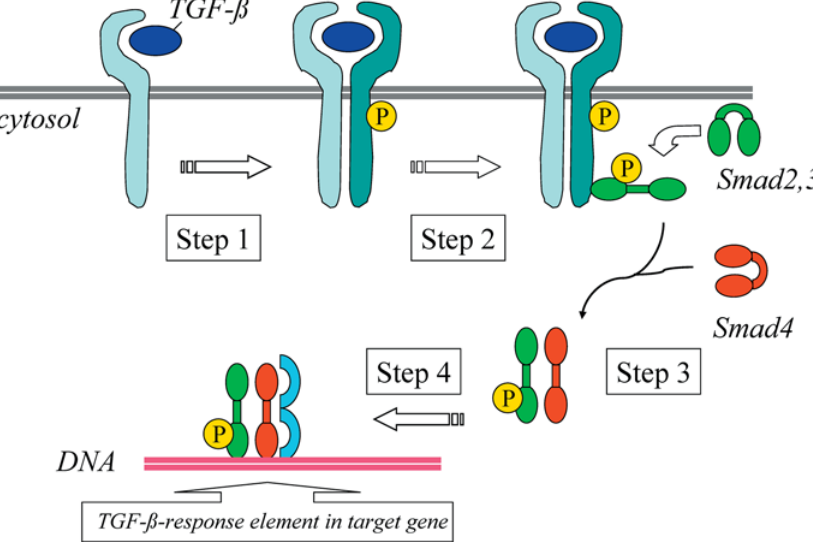
Figure 1. Simplifi ed Model for Smad-Dependent Signaling Pathway Activated by TGF β Showing the Consecutive Steps following TGF β Binding to the Type II TGF β receptor Step 1: TGF β binding to a type II receptor causes the receptor to recruit and phosphorylate a type I receptor. Step 2: phosphorylated type I receptor recruits and phosphorylates Smad2 or Smad3, upon which the Smads open up and expose a dimerization surface. Step 3: phosphorylated Smad2 or Smad3 dissociates from the receptor and oligomerizes with inhibitory Smad4. Step 4: the Smad2/3–Smad4 complex migrates to the nucleus, recruits other gene regulatory proteins (blue), and activates transcription of specifi c target